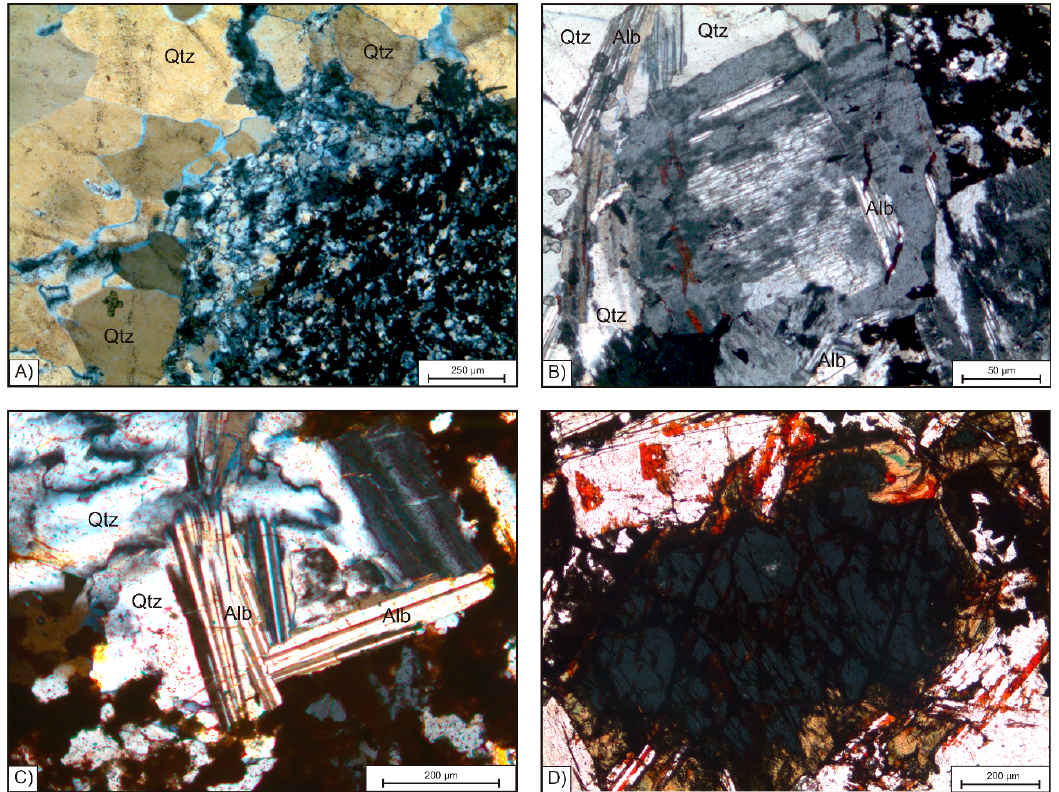
Figure 3. ( A ) Image of primary coarse quartz (Qtz) in sample KB G2 (yellowish interference color of quartz is due to section thickness > 30 µm) showing sub grain formation in adjacency to fine grained interstitial quartz intergrown with dark zircon-hematite aggregates. Optical microscopic image with cross-polarized light (xpl, transmitted light). ( B ) K-feldspar grain with irregular internal domains (xpl, transmitted light). ( C ) Lath shaped albite (Alb) crystals in interstitial volume of coarse grained quartz (xpl, transmitted light). ( D ) Arfvedsonite grain showing dark blue pleochroic color and typical cleavage, surrounded by aegirine (green pleochroic color). Lath-shaped albite (white to red) is colored red by fine grained hematite on lath planes. Microscopic image of KB G1 plain polarized light (ppl, transmitted light).